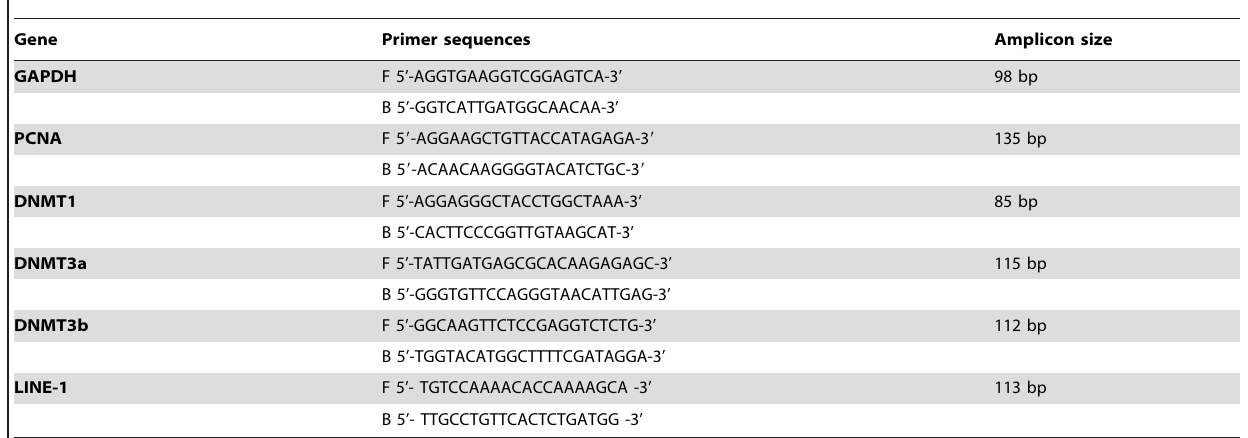
F: forward, B: backward. doi:10.1371/journal.pone.0096994.t001 PLOS ONE |